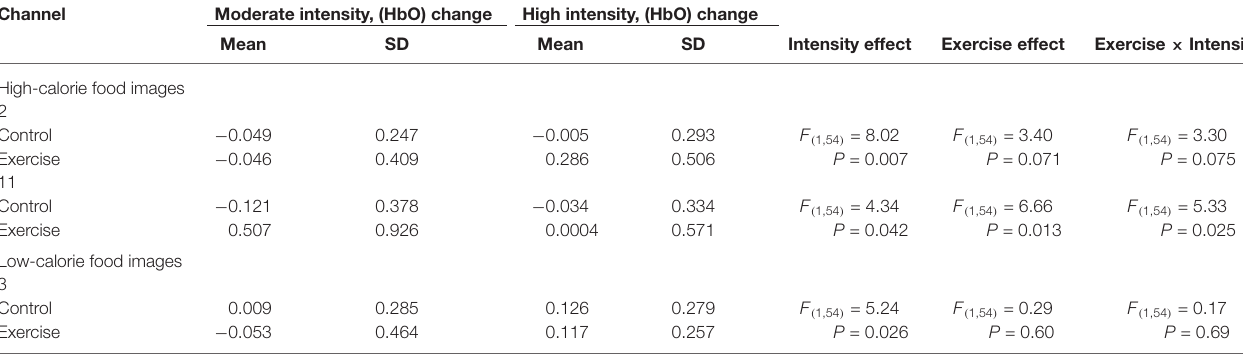
TABLE 2 | Main effects and interactions of viewing high-calorie and low-calorie food images separately in significant channels. Channel